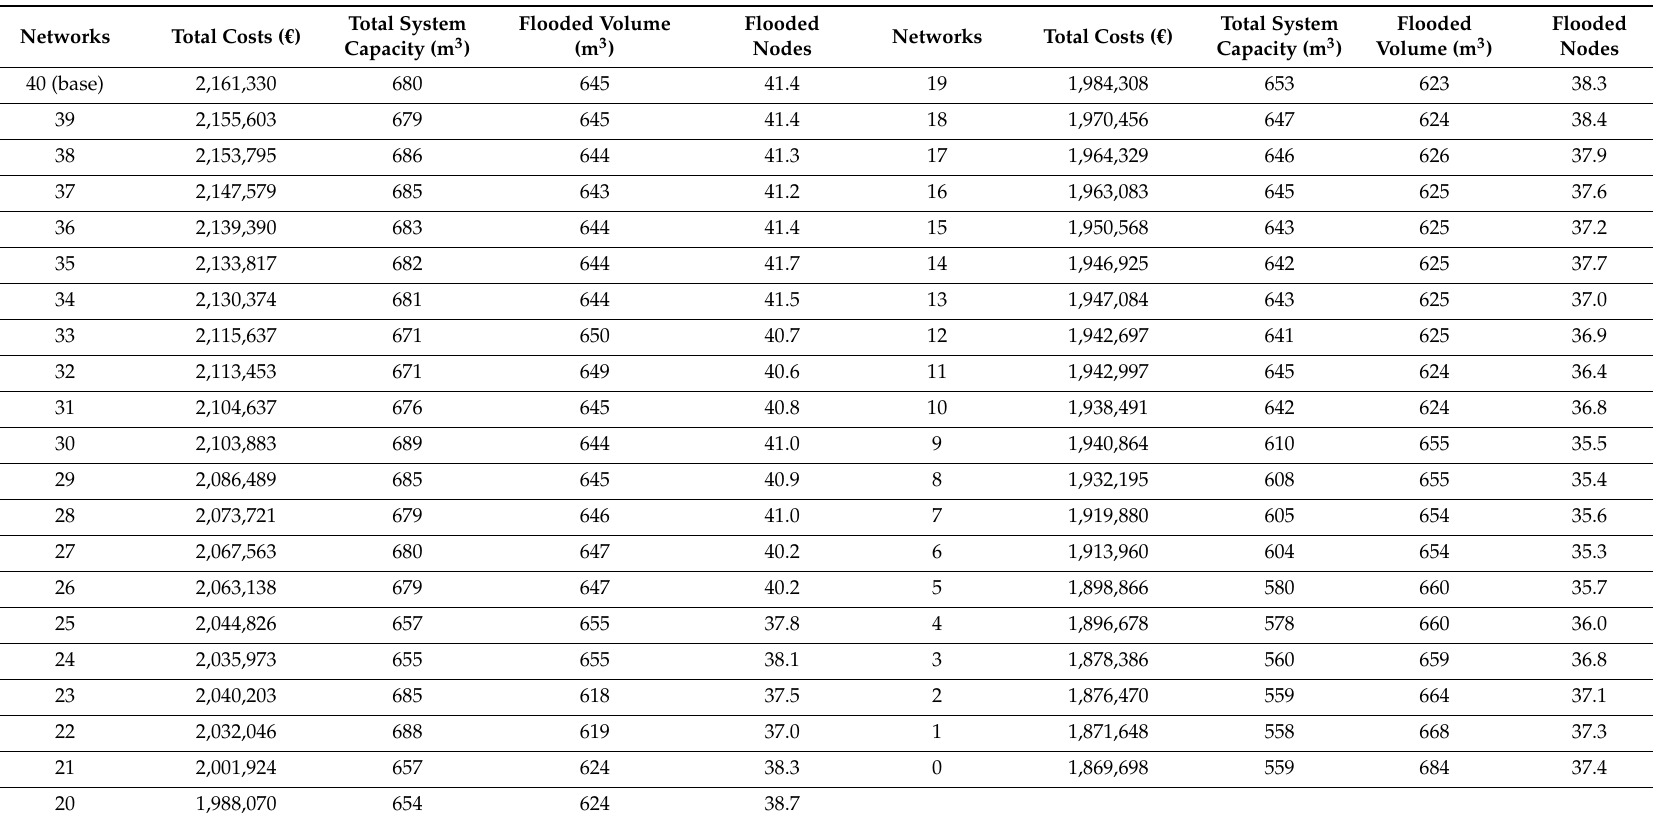
Table A1. Total construction costs ( € ), total system capacity (m 3 ), total weighted flooded volume (m 3 ) and total weighted number of flooded nodes for all 41 networks in which extra pipes are removed from upstream (scenario